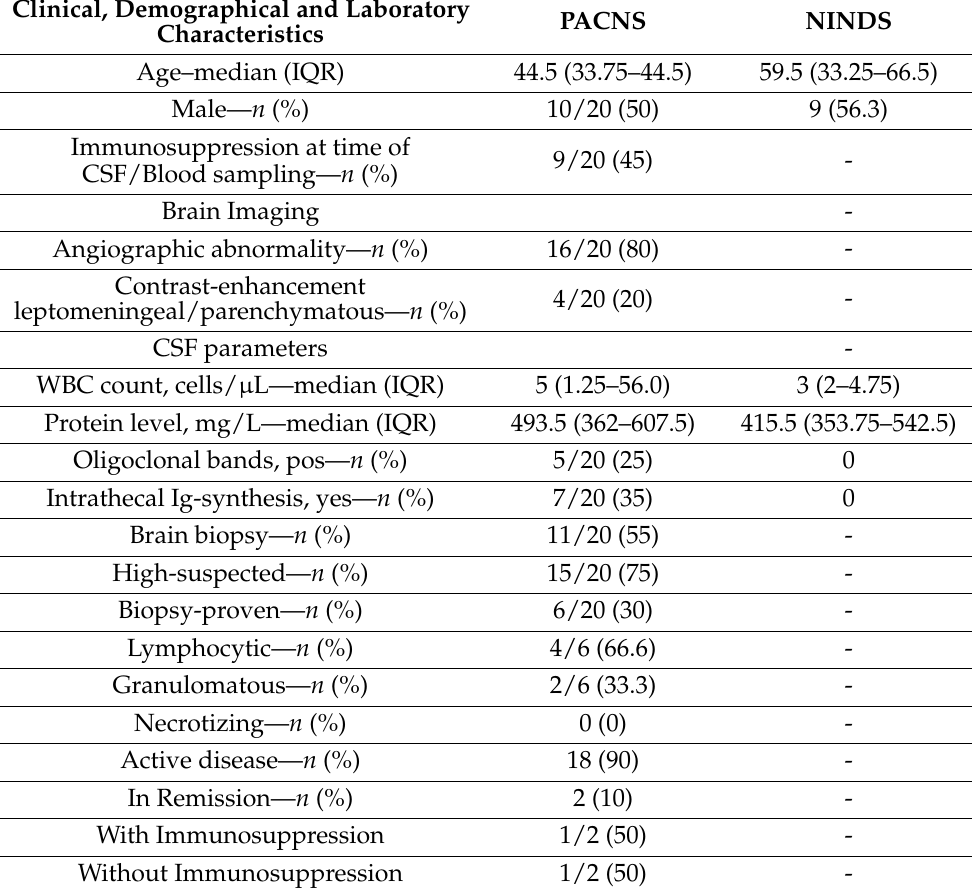
Table 1. Clinical, demographical characteristics and laboratory findings in patients with PACNS and